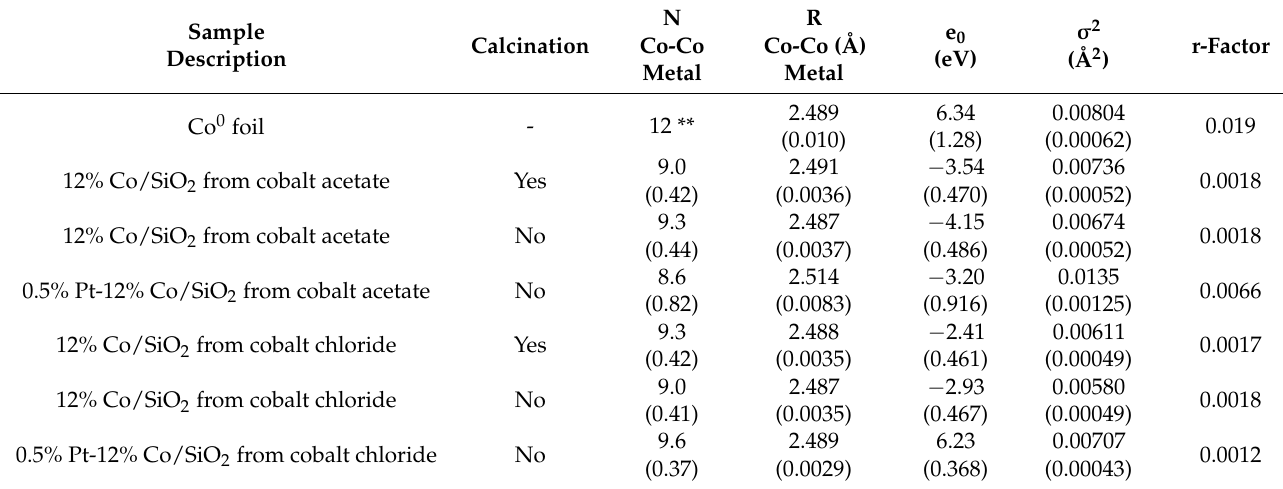
Table 2. EXAFS fittings for Co K-edge data for catalysts following TPR and cooling. Ranges: ∆ k = 3–10 Å − 1 ; ∆ R = 1.0–2.82 Å. S 02 was assumed to be 0.90. ** Fixed